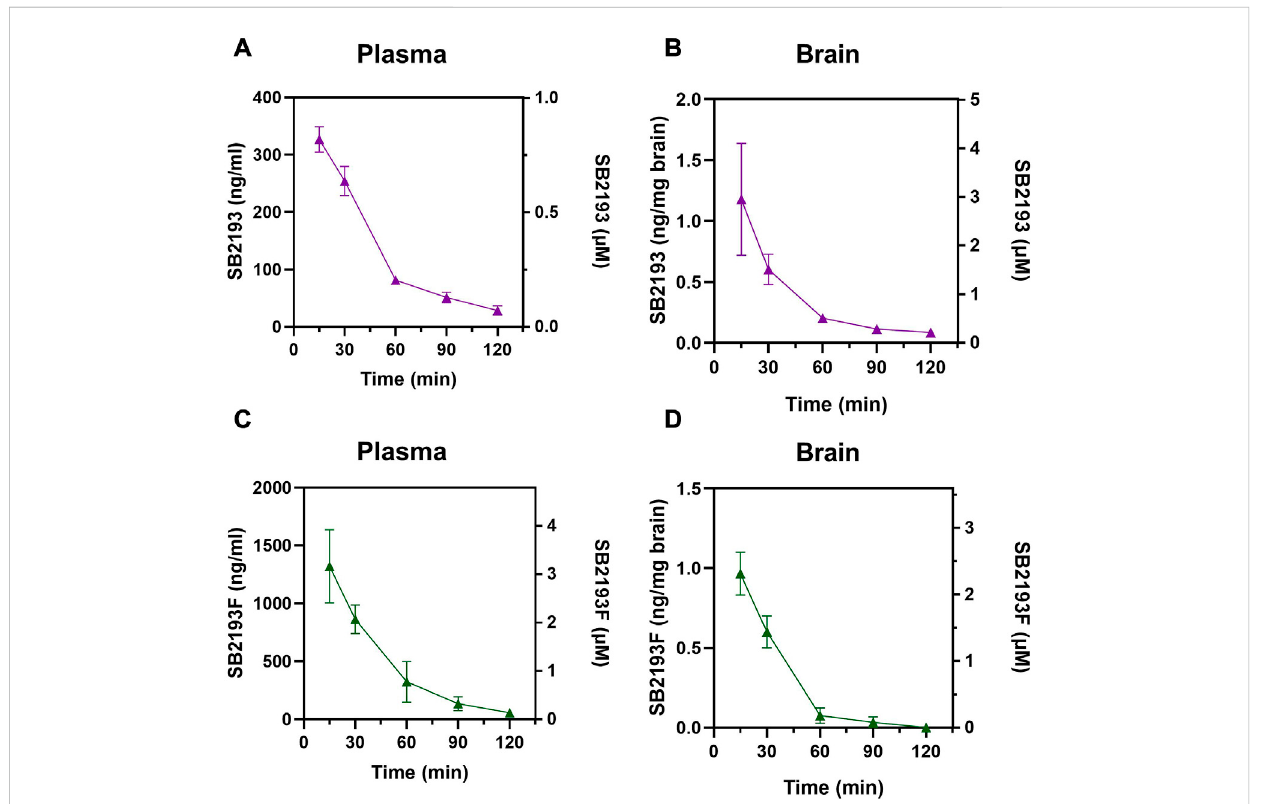
FIGURE 5 Pharmacokinetic analysisofMEPIRAPIManaloguesinmouseplasmaandbrainsamples.Concentration-timecurvesforSB2193inmouseplasma (A) and brain (B) and SB2193F in mouse plasma (C) and brain (D) following 10 mg/kg i.p. injections. Data are expressed as mean ± SEM with n = 4 per timepoint.